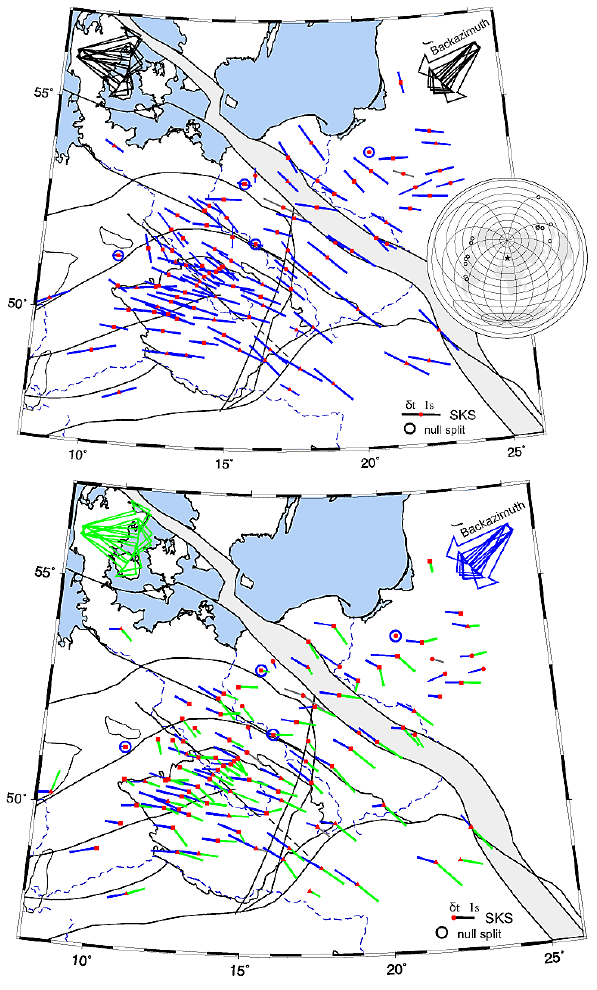
Figure 6. Shear-wave splitting presented in a standard way, i.e. the fast shear-wave polarization azimuths (Supplement Table S1) as bars with length proportional to the split delay time: (a) averages calculated from all measurements regardless of wave back azimuth and (b) averages calculated separately for waves arriving from the west and from the northeast. Inset shows epicentre distribution of 15 events used in this study relative to the PASSEQ array (star).